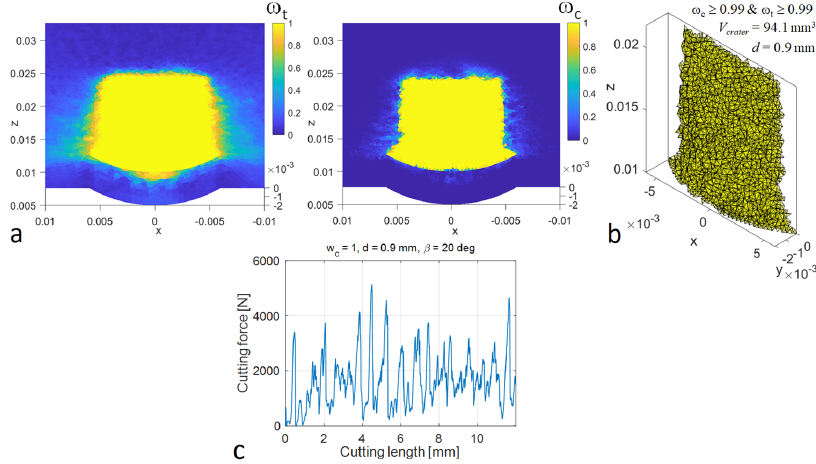
Figure 7. Simulation results for PDC cutting with 𝑤 (cid:2913) (cid:3404) 1 ( d = 0.9 mm, β = 20°): ( a ) tensile and com ‐ pressive damage fields; ( b ) removed elements; ( c ) cutting force vs. cutting length.